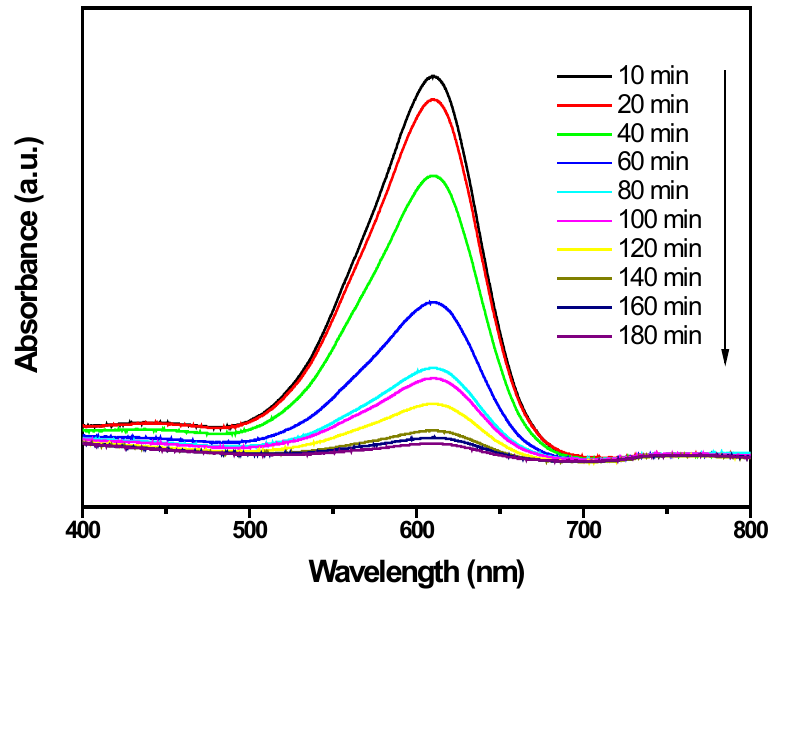
calcinated at 800 °C for 35 4